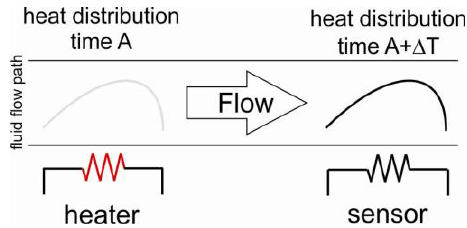
Figure 3. Illustration showing concept of time-of-flight